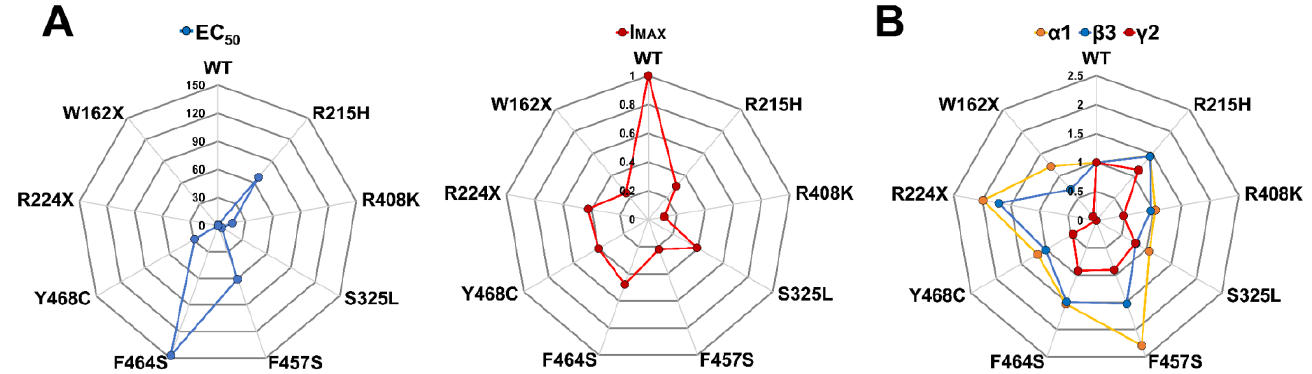
Figure 7. GABA A receptor impairment profile caused by mutant γ 2 subunits. Spider plots of the GABA A R expression and function compare the impairment magnitude caused by mutant γ 2 subunits. ( A ) The EC 50 and I MAX of GABA A R containing mutant γ 2 subunits were normalized against WT. The data are related to the assays shown in Figures 4 and 5. ( B ) Surface and total expression of GABA A R co-expressing WT α 1, β 3, γ 2, and mutant γ 2 subunits were normalized against WT. These data are related to the assays shown in Figure 6. Values other than 1 indicate a loss (<1) or gain (>1) effect.